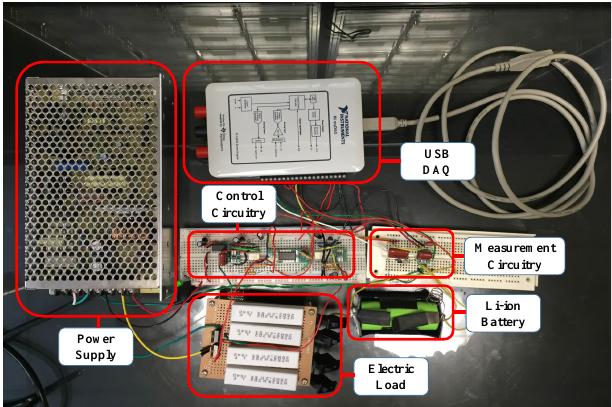
Figure 4. Photograph of the experimental battery